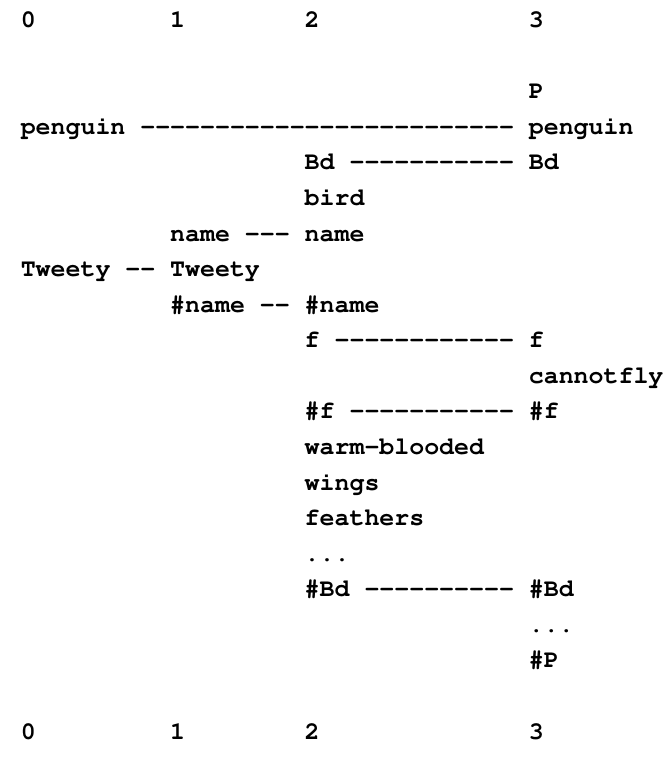
Figure 21. A Bayesian network representing causal relationships discussed in the text. In this diagram, “Phone call” means “a phone call about the alarm going off” and “Radio announcement” means “a radio announcement about an